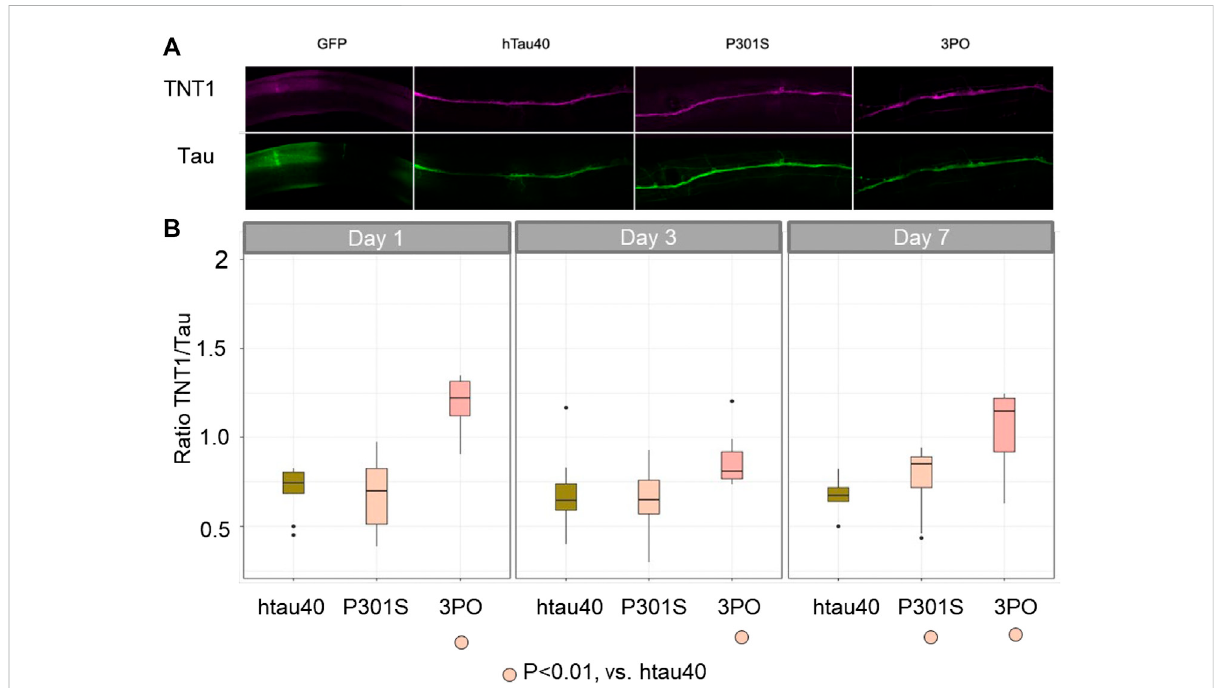
FIGURE 9 TNT1stainingindicates tau canadoptdisease-relevantconformations in C. elegans Weused theTNT1 antibodyand A002401 antibodyto stain animals for the early disease conformation aggregates compared to total tau. (A) Day one adult animals stained with TNT1 (magenta) and total Tau (green)antibodies. (B) Wequanti fi edthestainingondaysone,threeandsevenofadulthood( N =10perdaypergenotype),derivingtheratioofTNT1/ Total tau. The 3PO lines had a higher ratio of pathogenic tau than hTau40 or P301S, which were not signi fi cantly different from each other on day one. By day seven the TNT1 immunoreactivity was signi fi cantly increased in the P301S animals compared to hTau40 (ANOVA, Tukey post-hoc comparison, p <